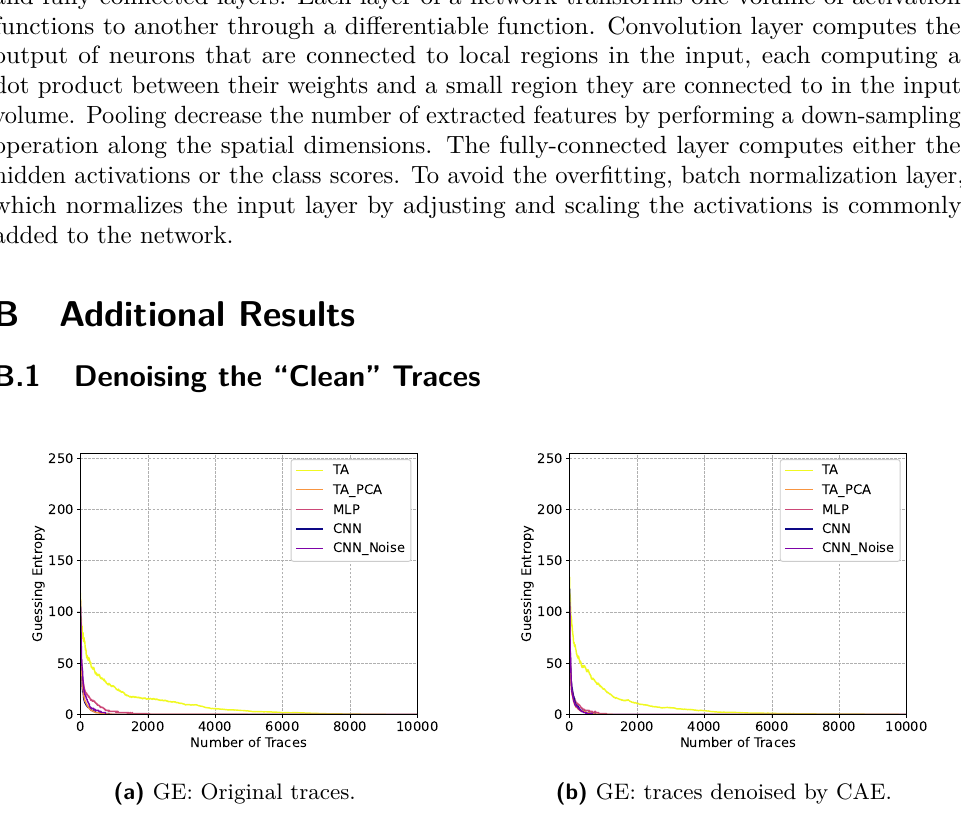
Figure 15: Guessing entropy: original traces vs “cleaned” traces by